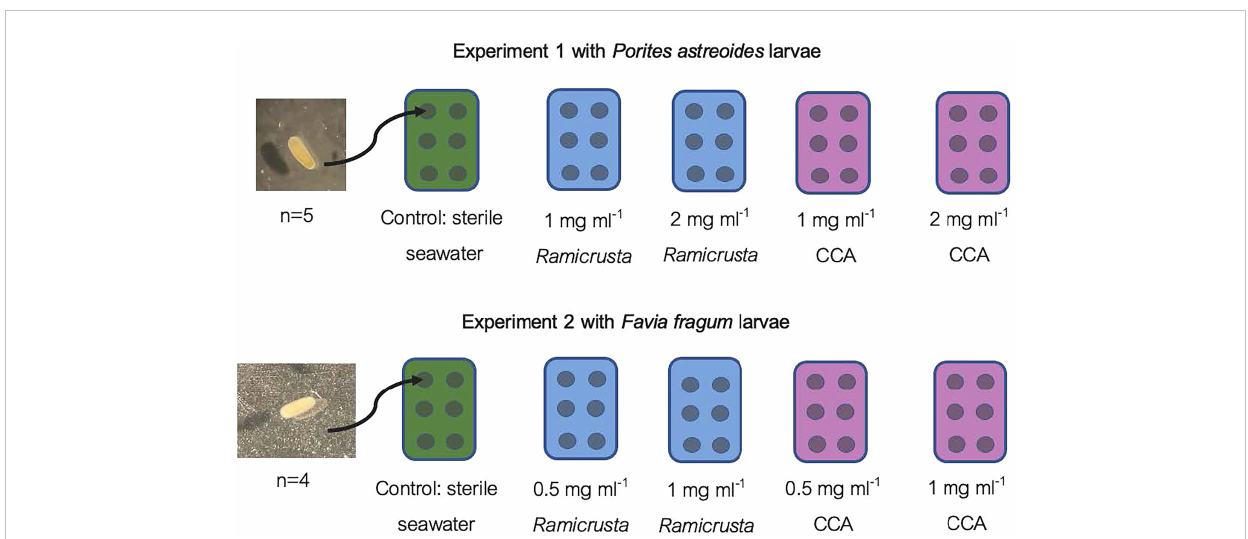
FIGURE 1 The experimental design for the larval exposure experiments. Each rectangle with six circles represents a 6-well plate and the circles represent 16.8 ml wells containing larvae and treatment. Green represents the sterile seawater, blue represents solutions containing Ramicrusta , and pink represents a solution containing CCA. Each well contained 10 ml of the solution or sterile seawater, and 5 wells each containing 4-5 larvae were examined per